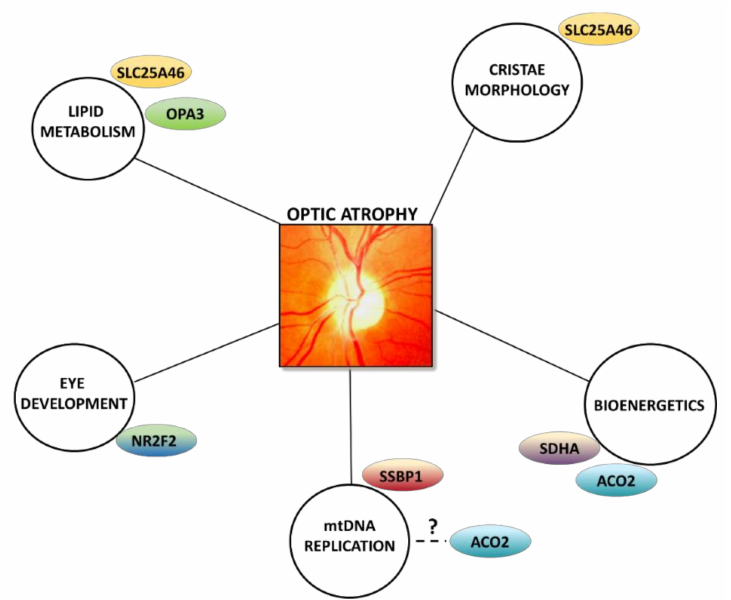
Figure 5. Additional pathways involved in optic atrophy. Schematic representation of different pathways converging on optic nerve degeneration, involving several genes associated with optic atrophy. A pale optic nerve head is shown at the center of the